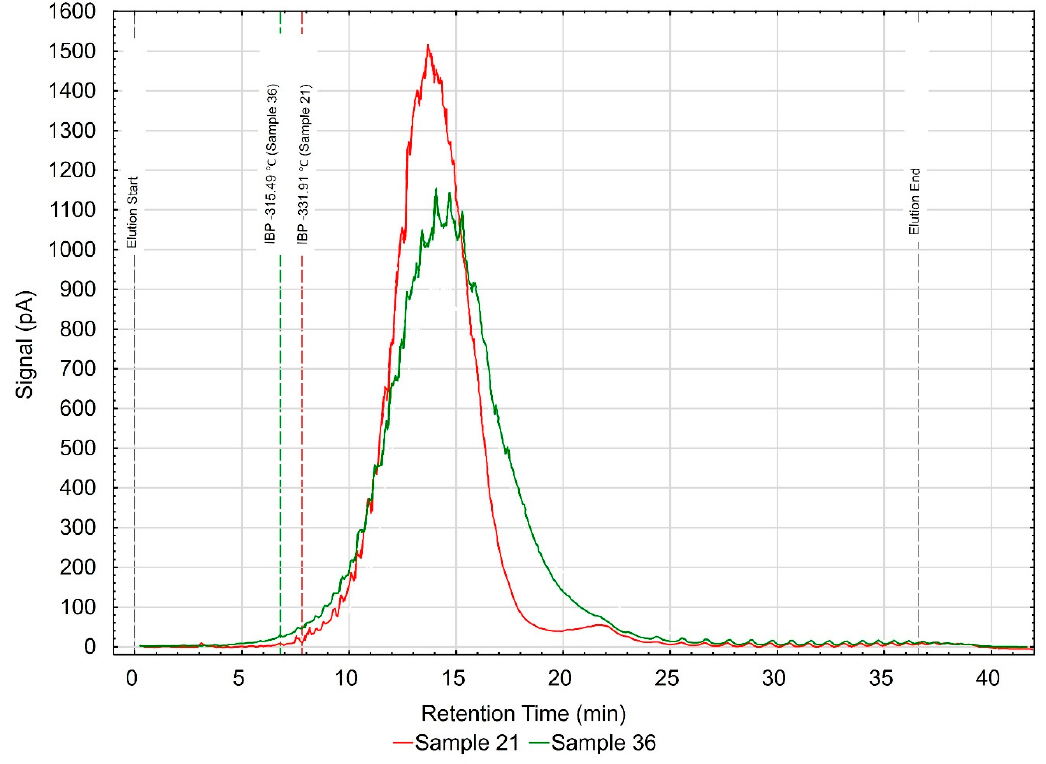
Figure 11. Chromatographic analysis.